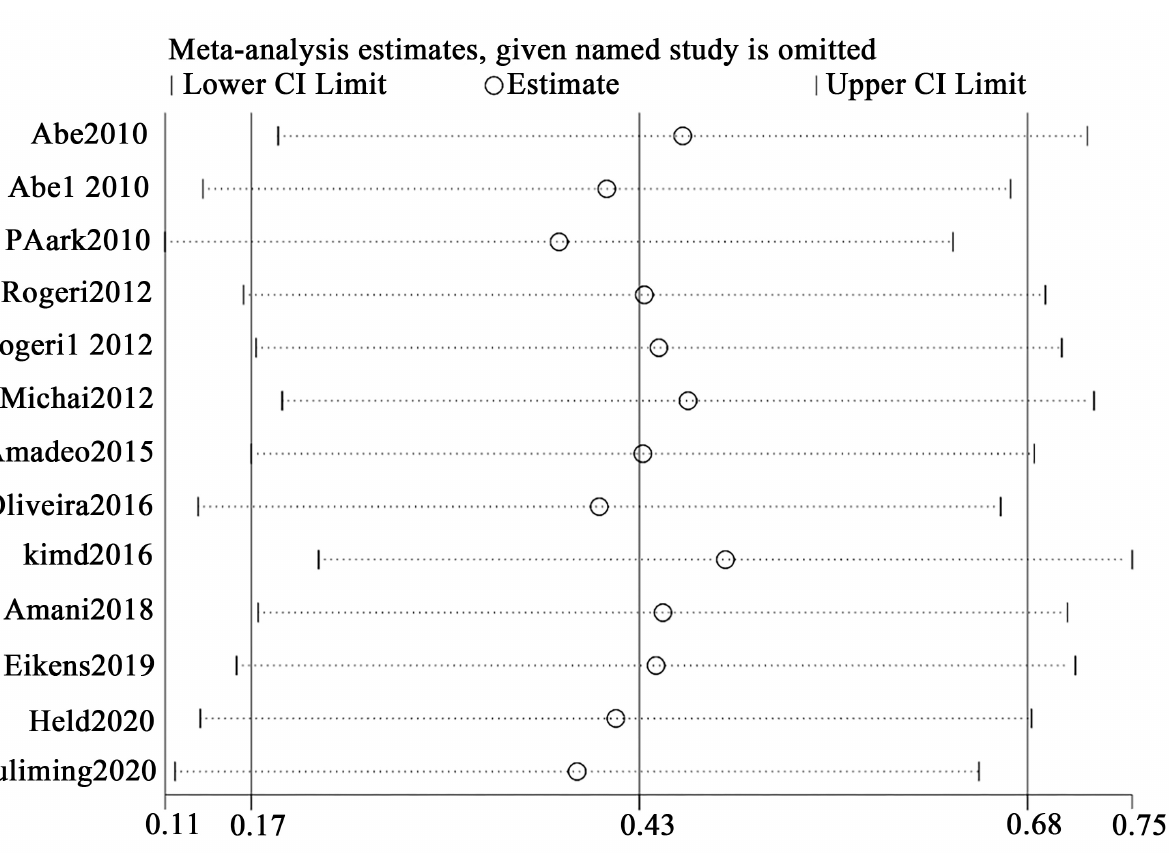
Fig. 6. Sensitivity analysis